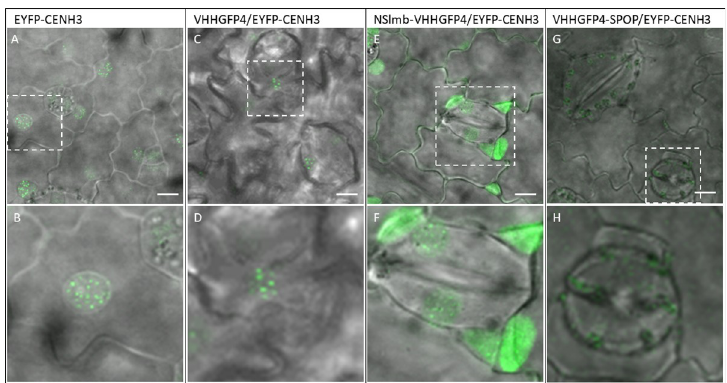
Fig 4. Confocal microscopy analysis of transgenic N . tabacum leaves. (A and B) Transgenic plants accumulate EYFP-CENH3- within centromeric regions. (C and D) EYFP-CENH3- and VHHGFP4 co-expression. Nanobody without fusion partner binds EYFP but does not result in a signal reduction. Any signal modulation (reduction or translocation) must be induced by the fusion partner (SPOP/NSlmb). (E and F) Coexpression of YFP-CENH3- and NSlmb-VHHGFP4. We observed translocation of the fluorescence signal to the nucleoplasm. (G and H) Co-expression of EYFP-CENH3 and VHHGFP4-SPOP. Strong reduction of the target protein. Scale bar: 10 μ m. Magnification 40x. For all genotypes leaf material of 10 independent transgenic lines was